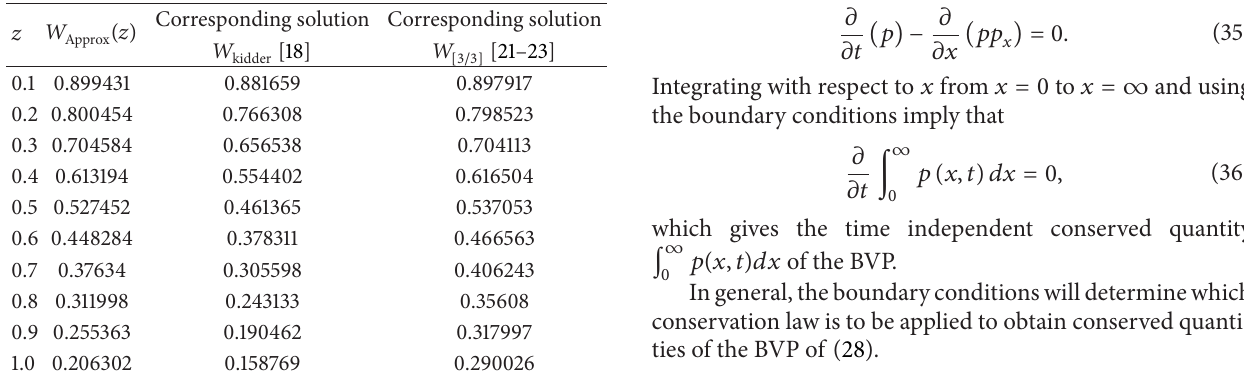
Table 1: Solution values for 𝛼 = 0.5